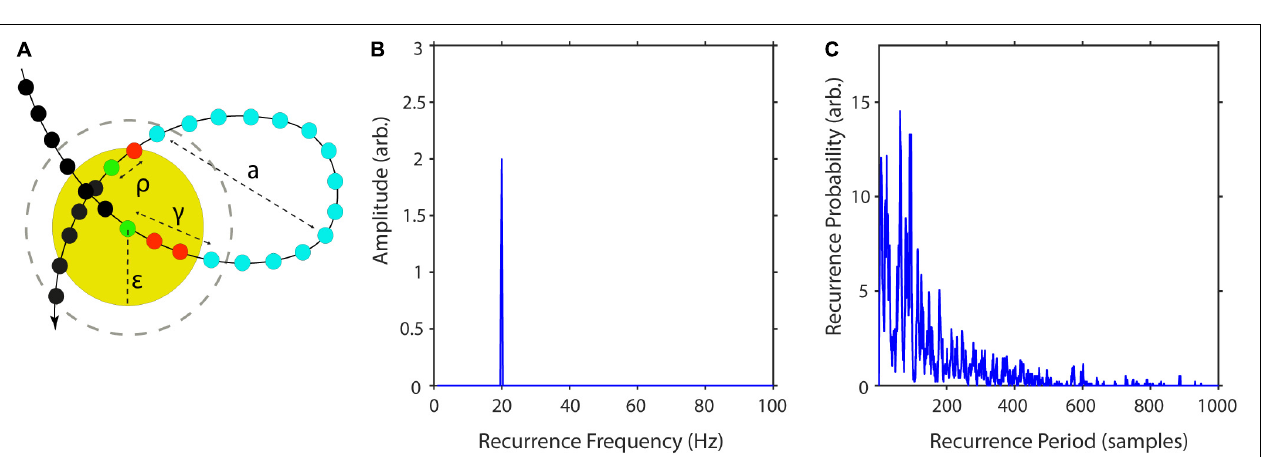
FIGURE 1 | Examples of recurrence plots. At each time i, each black dot indicates a spatial recurrence at time j. Parallel lines indicate periodic activity. Recurrence plots show characteristic patterns, depending on the system’s qualitative dynamics: (A) Random white noise. (B) Sinusoid with a period of 100 samples. (C) A recurrence plot of a classic deterministic nonlinear system, i.e., the Lorenz system (Lorenz, 1963).